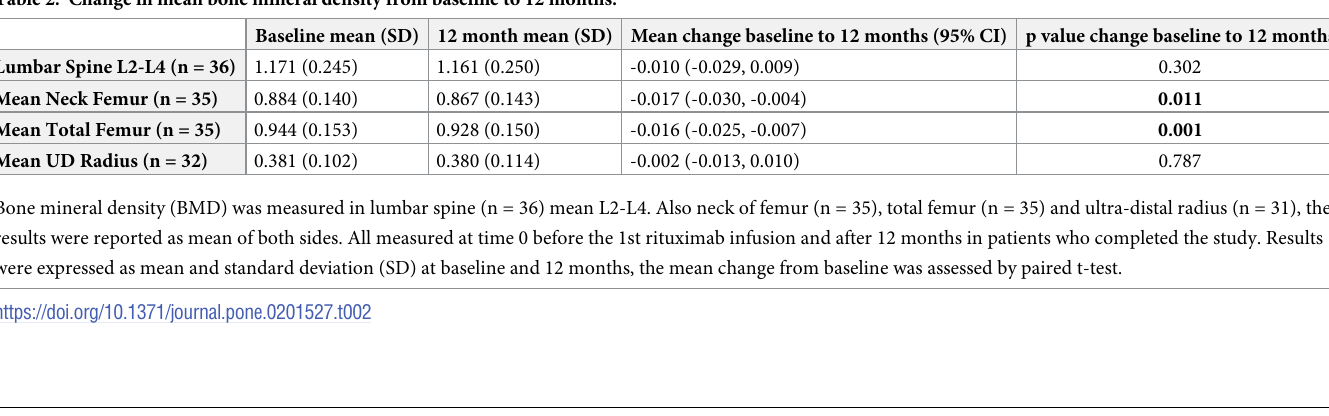
Table 2. Change in mean bone mineral density from baseline to 12